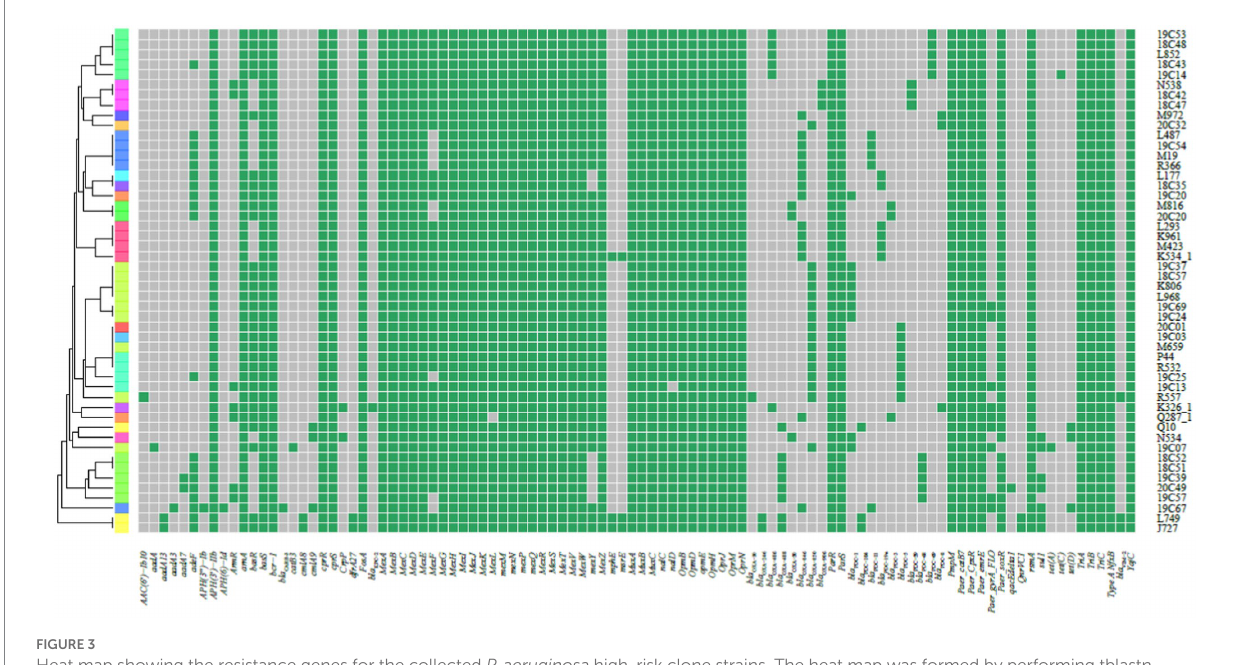
FIGURE 3 Heat map showing the resistance genes for the collected P. aeruginosa high-risk clone strains. The heat map was formed by performing tblastn searches using the sequences present on the Comprehensive Antibiotic Resistance Database (CARD) as queries and the genomes as subjects. Grey indicates the absence, and green indicates the presence of the resistance